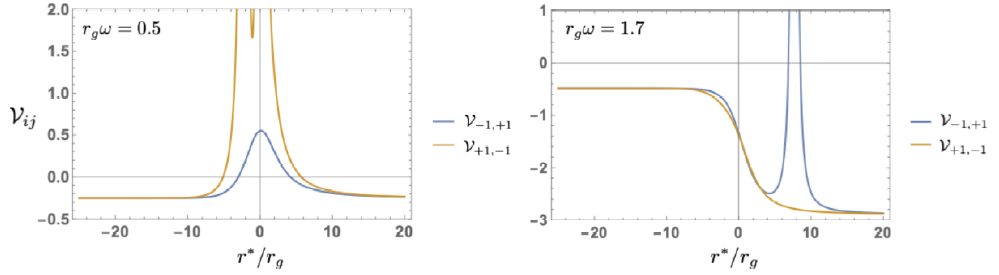
1, + 1 ) and (+ 1, 1 ) for ¯ a = 0.8 and (cid:96) = m = 2. The potential − −